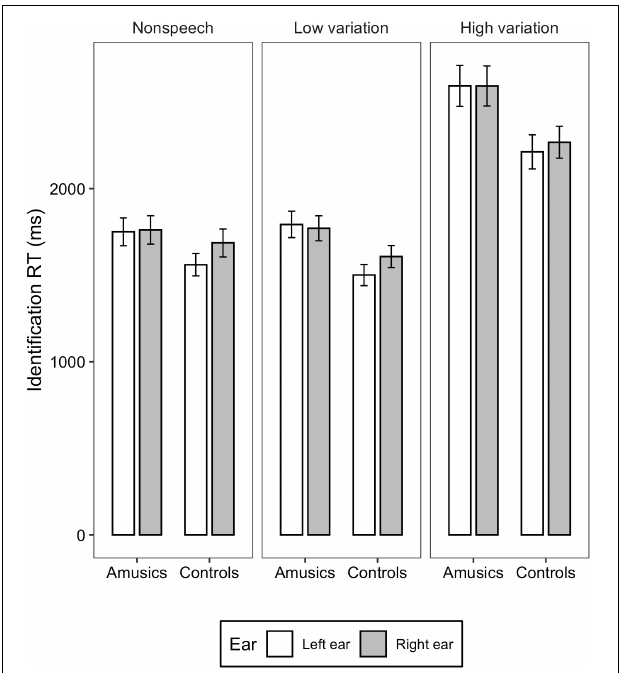
FIGURE 2 | Bar charts showing the identification RT (means and CIs) for amusic and control participants in the three stimulus conditions: Non-speech, Low variation, and High